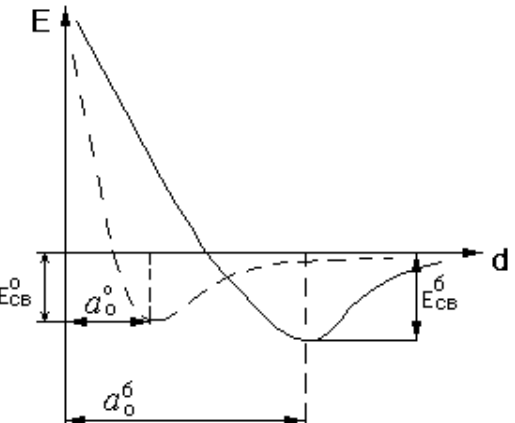
Figure 23. Changes in the binding energy during the approach of atoms in liquid metals under the influence of EMP: a 0 0 and a b 0 —interatomic distances in initial and treated liquid metals, respectively; E δ CB and E 0 CB are the binding energies in initial and treated liquid metals [47].